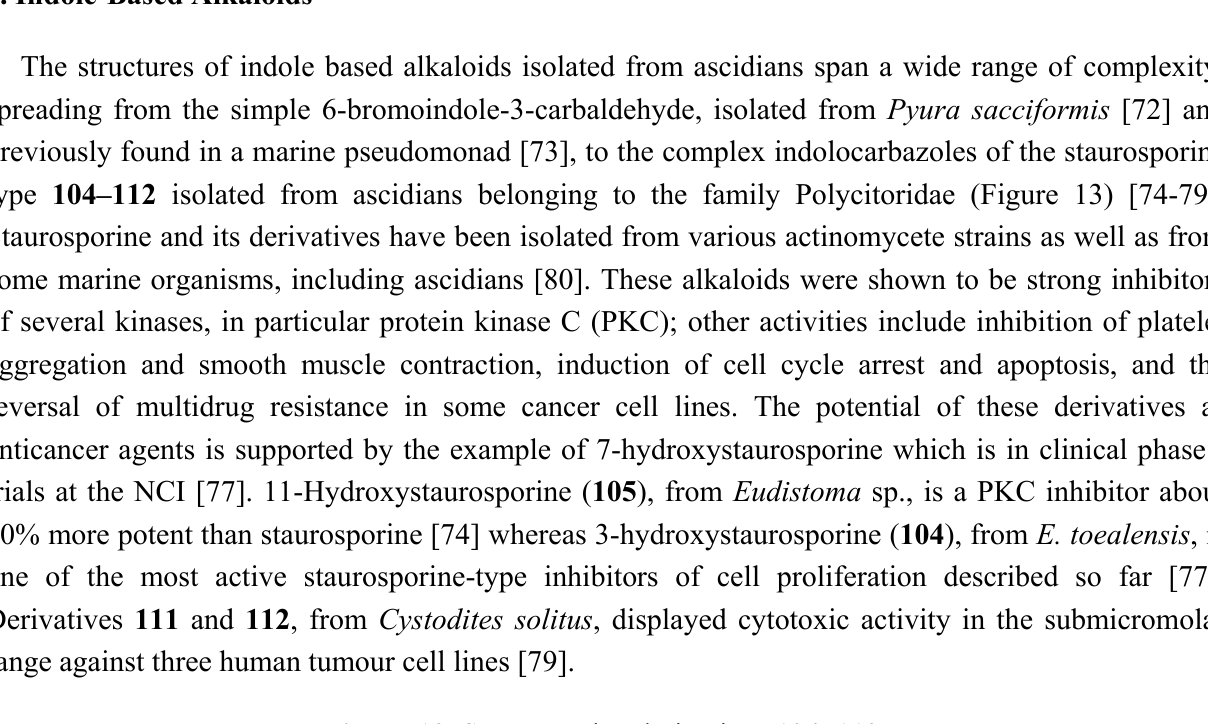
Figure 13. Staurosporine derivatives 104–112